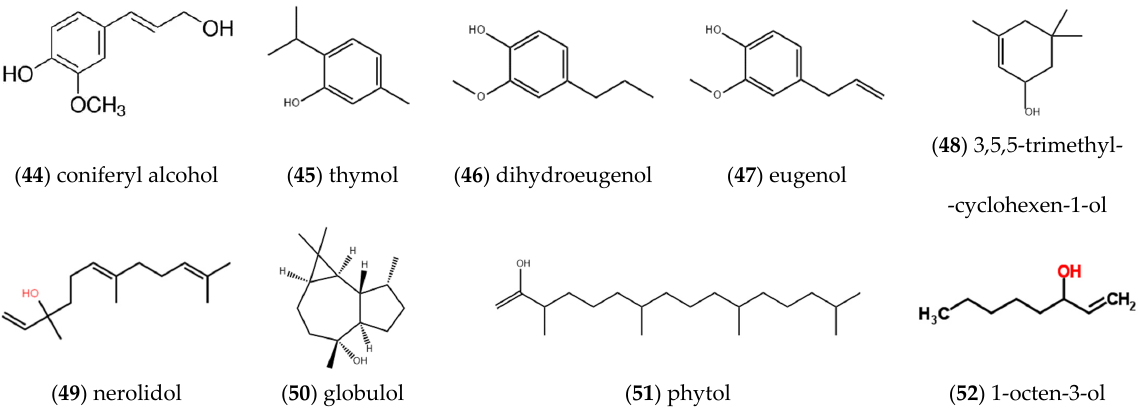
Figure 4. Structures of alcohols and phenolic compounds isolated from ST .